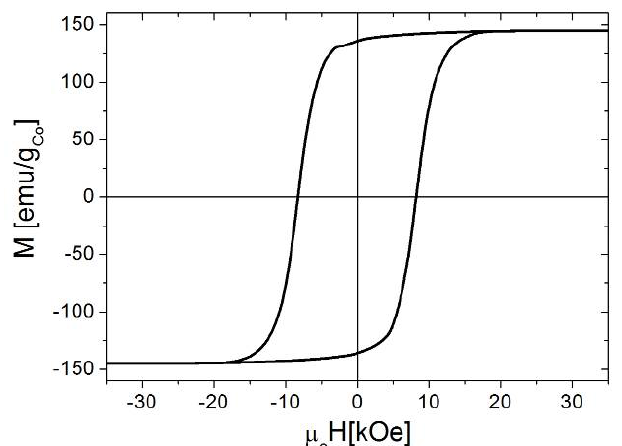
Figure 9. Typical hysteresis loop of a P41Boba +1 wt% Co composite at 300K Before the measurement the sample has been heated up during 10 min in the isotropic phase (400 K) in order to erase any possible magnetic history effect, then it has been cooled down in the presence of a 5T magnetic